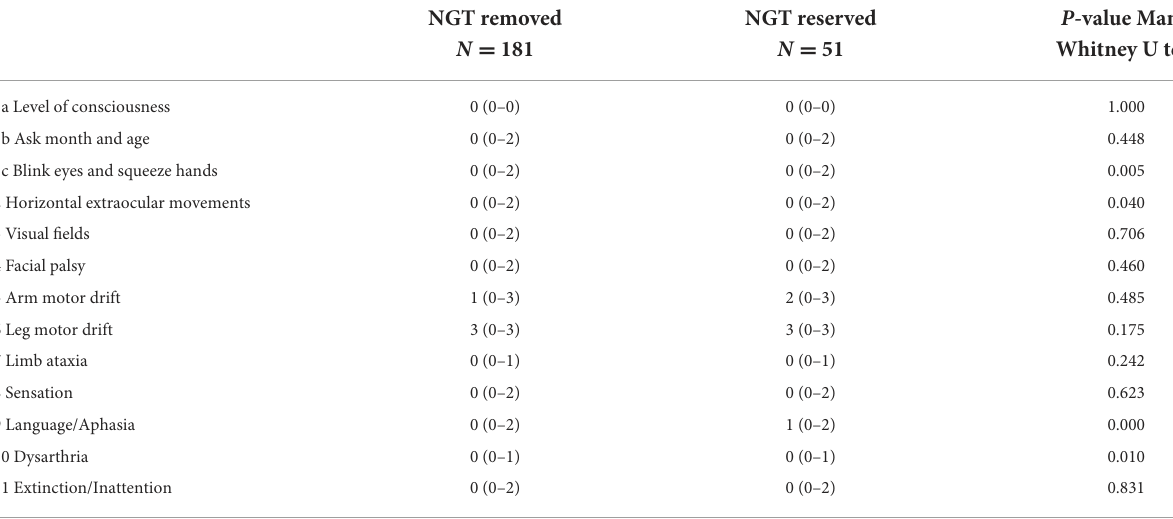
TABLE 4 Risk factors of NIHSS subscores for removal of NGT in patients with PSD.